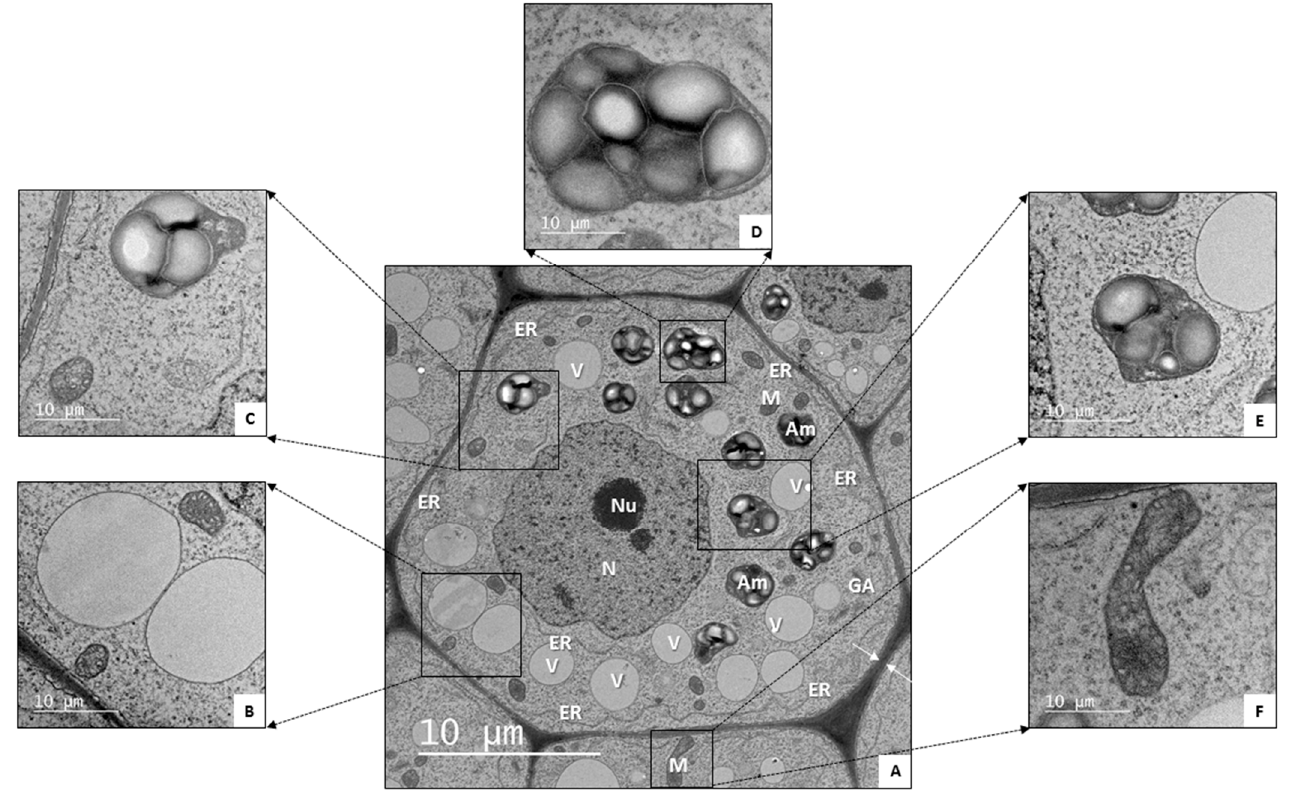
Figure 4. Central columella cells in the root tip of Zea mays . Micrographs demonstrating architecture of the RC statocytes ( A ) by means of transmission electron microscopy (TEM; JEM-2100 JEOL, Tokyo, Japan, operating at 200 kV), and a more detailed ultrastructural organization of the tubular type of mitochondria ( B , F ), and starch-rich plastids (amyloplasts) ( C–E ). Note: N—nucleus, Nu— nucleolus, V—vacuole, ER—endoplasmic reticulum, Am—amyloplast, M—mitochondrion, GA— Golgi apparatus, facing arrows—cell wall; scale bars: 10 µm (magnification ×800 ( A ); ×4000 ( B , C , E ); ×6000 ( D , F )).